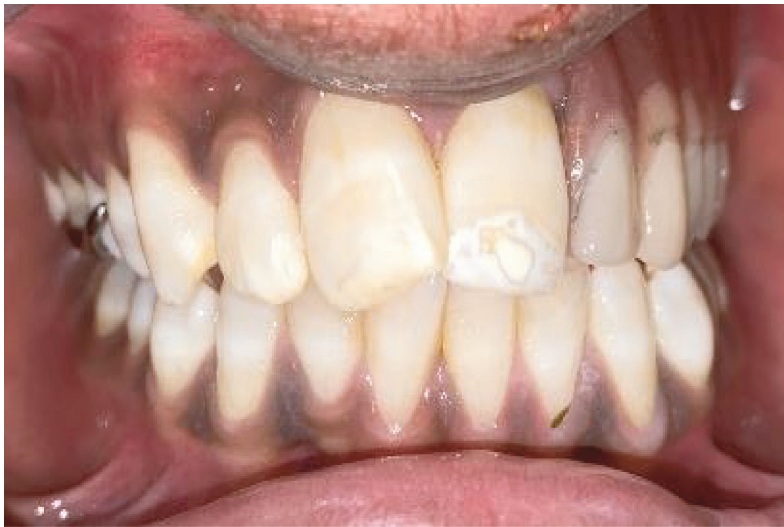
Figure 8: Final prosthesis.